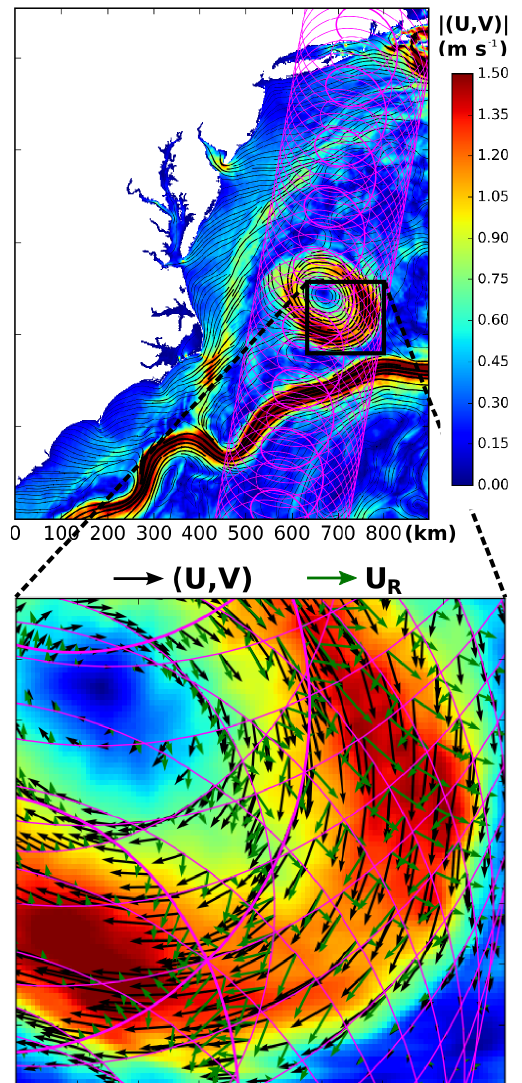
Figure 7. Illustration of current components U and V and radial component U R in the case of the Gulf Stream.